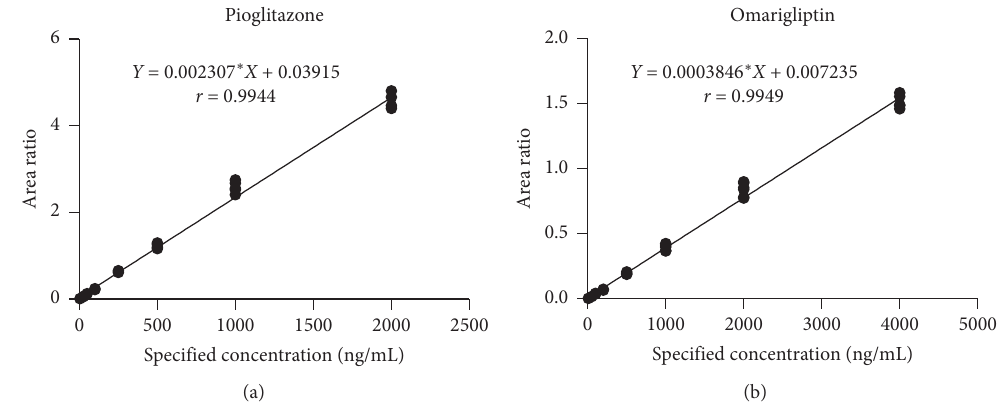
Figure 4: Calibration curves for pioglitazone (5–2000ng/mL) and omarigliptin (10–4000ng/mL) over 3 days.